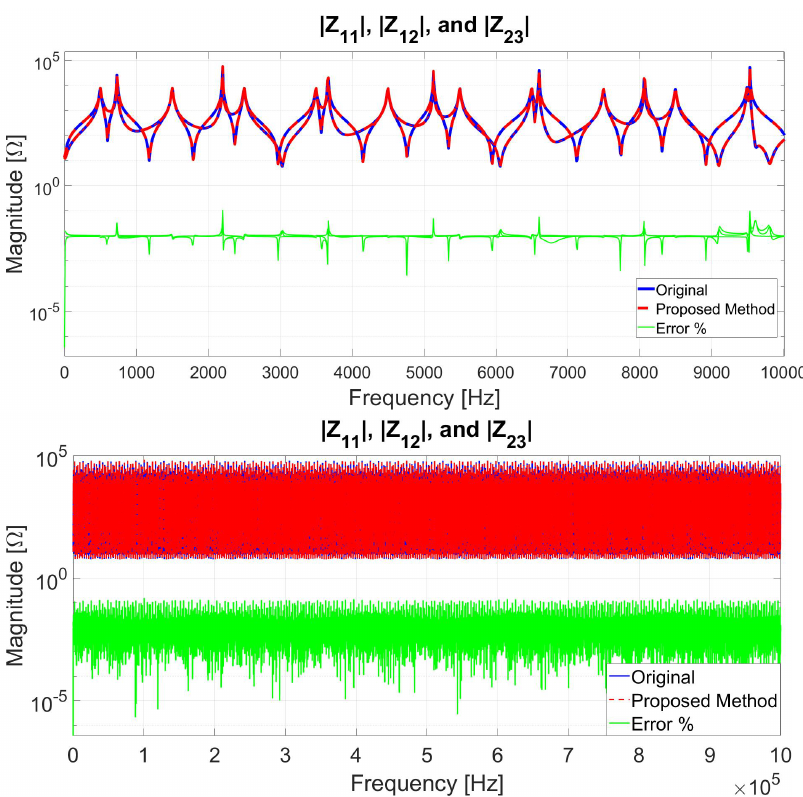
Figure 25. The magnitude of the measured and fitted impedance using the proposed model, | Z 11 | , | Z | , and | Z | 23 12